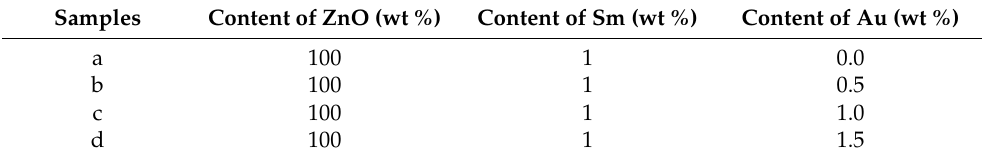
Table 1. Parameters specifying fabrication of Au (0.0, 0.5, 1.0 and 1.5 wt % )-doped ZnO–Sm nanoparticles.